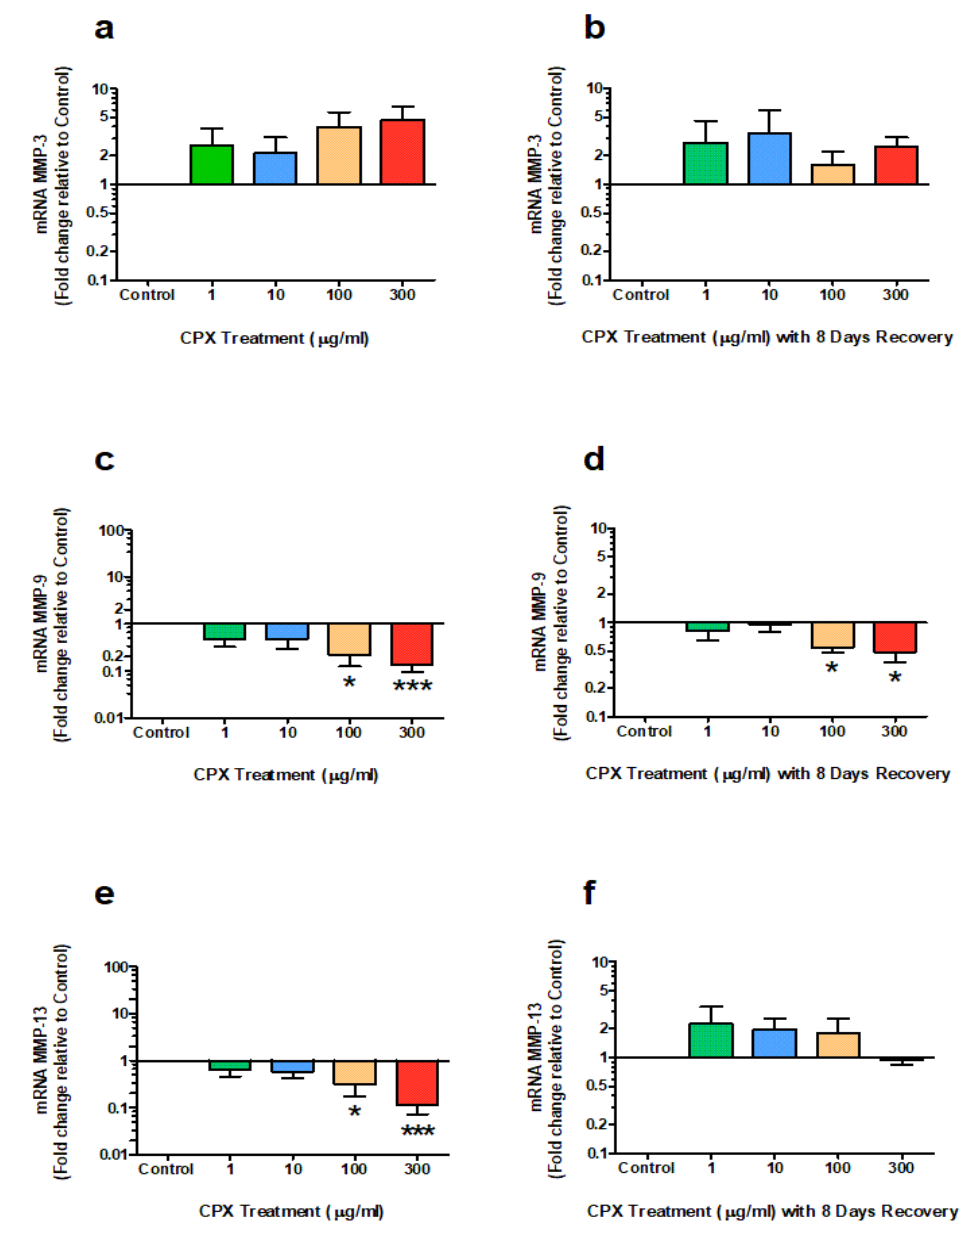
Figure 3. m RNA expression of MMP-3 ( a , b ), MMP-9 ( c , d ) and MMP-13 ( e , f ) after 4 days treatment with 1, 10, 100 & 300 µ g/mL CPX and subsequent 8-day recovery period in equine derived tendon explant cultures (n = 4). Data are expressed logarithmically. Values represent mean ± SEM and are expressed as fold change relative to control, normalised to GAPDH. * p < 0.05, *** p < 0.001 vs. control.